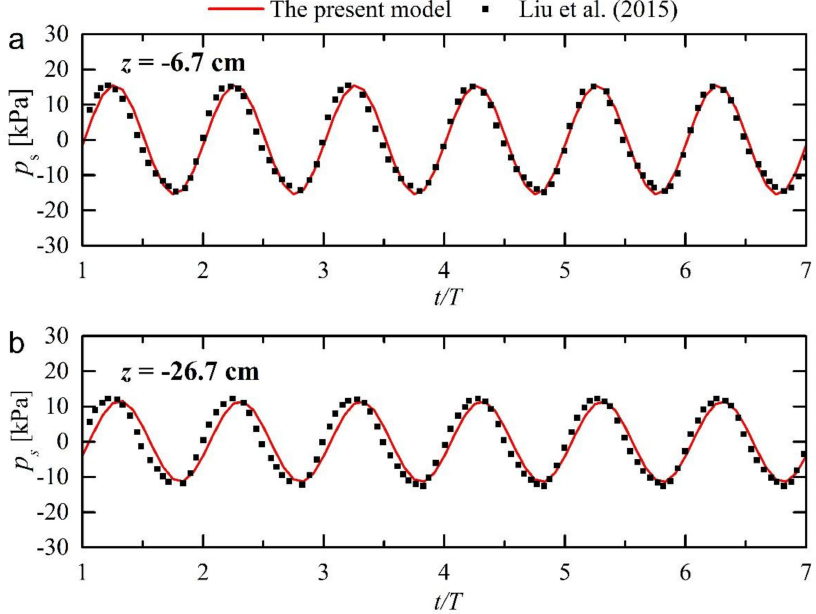
Figure 2. Validation of time series of pore pressure against experiment data of Liu et al. [36] at depths ( a ) z = − 6.7 cm and ( b ) z = − 26.7 cm (Adapted from Tong et al.